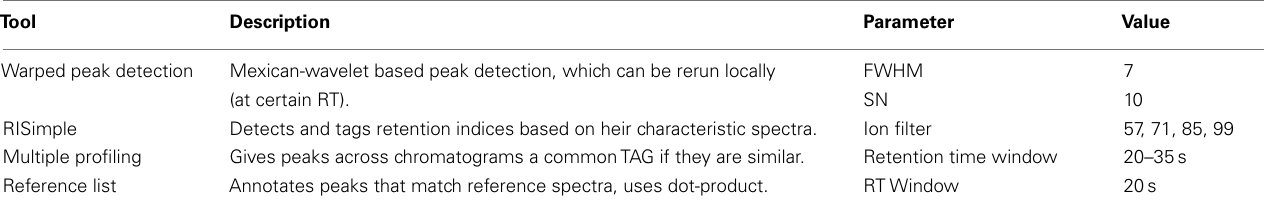
Table 1 | Parameters that were applied for preprocessing tools